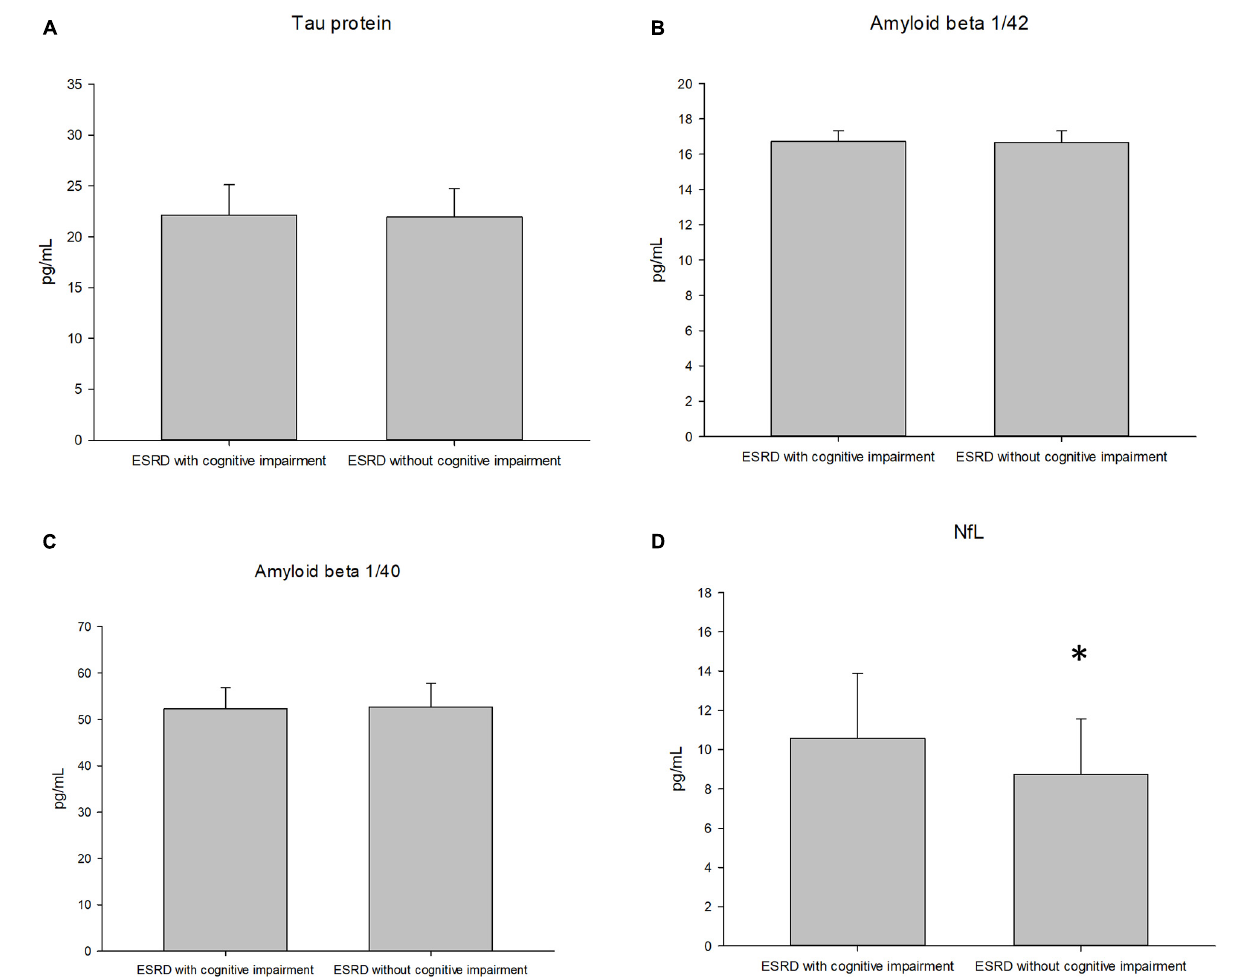
FIGURE 1 | The plasma concentration of the tau protein (A) , amyloid 1/42 (B) , amyloid 1/40 (C) , and neurofilament light chain [NfL, (D) ] between groups of the subjects.